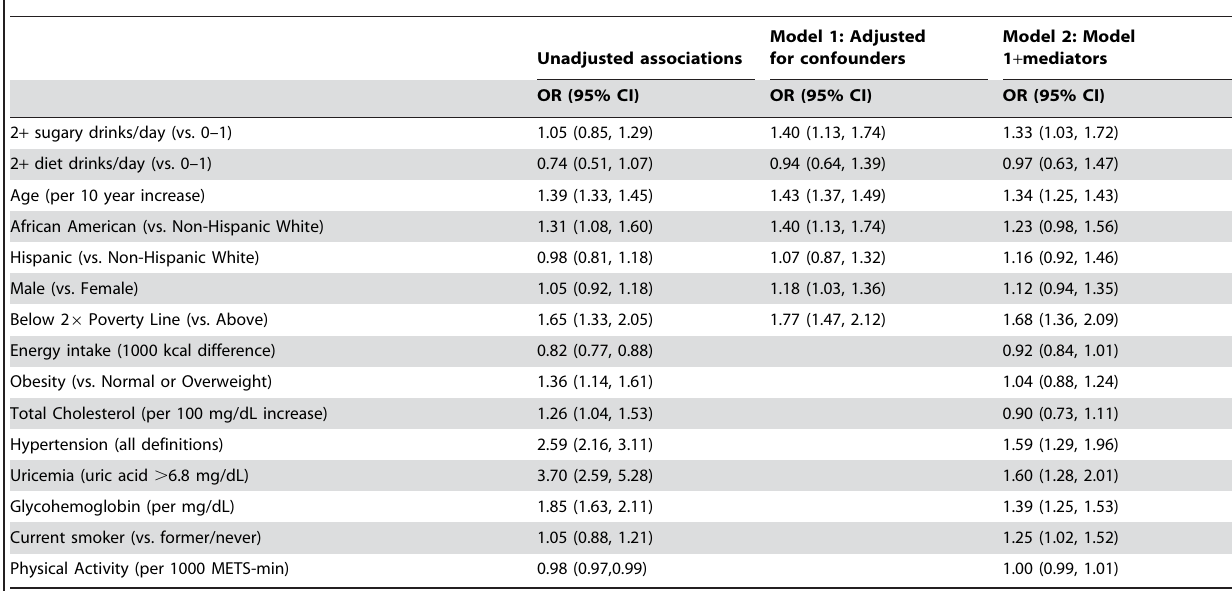
Table 3. Unadjusted and adjusted Odds Ratios (OR) and 95% Confidence Intervals (95%CI) for